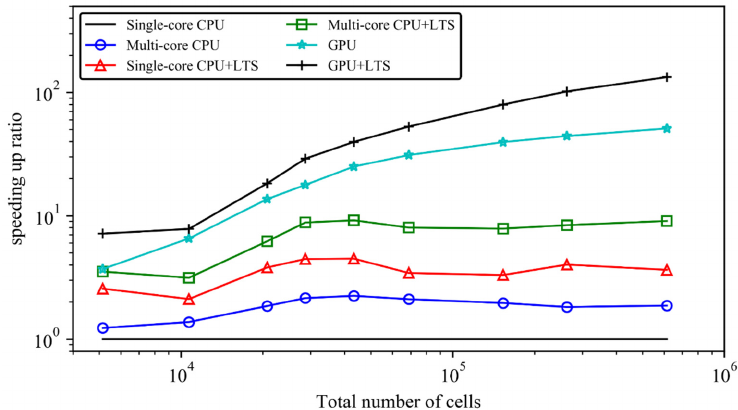
Figure 7. Speeding-up ratios of the six SWM versions for simulations of the experimental dam-break flows propagating through buildings, as compared to the single-core CPU version. flows propagating through buildings, as compared to the single-core CPU